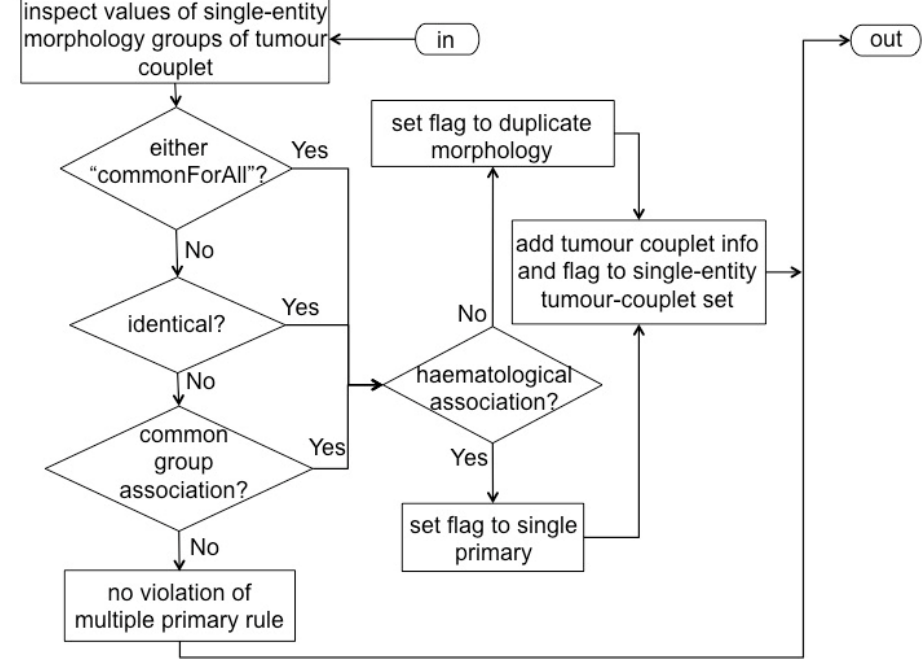
Figure A4. Process–encapsulated in connector “IV” in Figure A3–For determining whether the two single-entity morphology groups are equivalent for a given tumour-pair permutation.